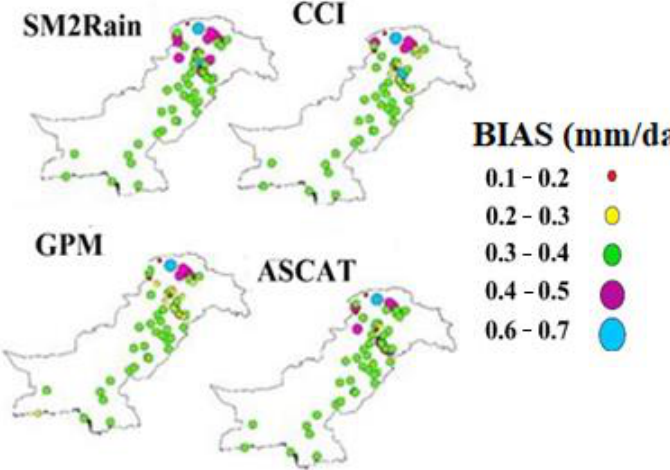
Figure 8. BIAS’s spatial distribution of all SPPs .